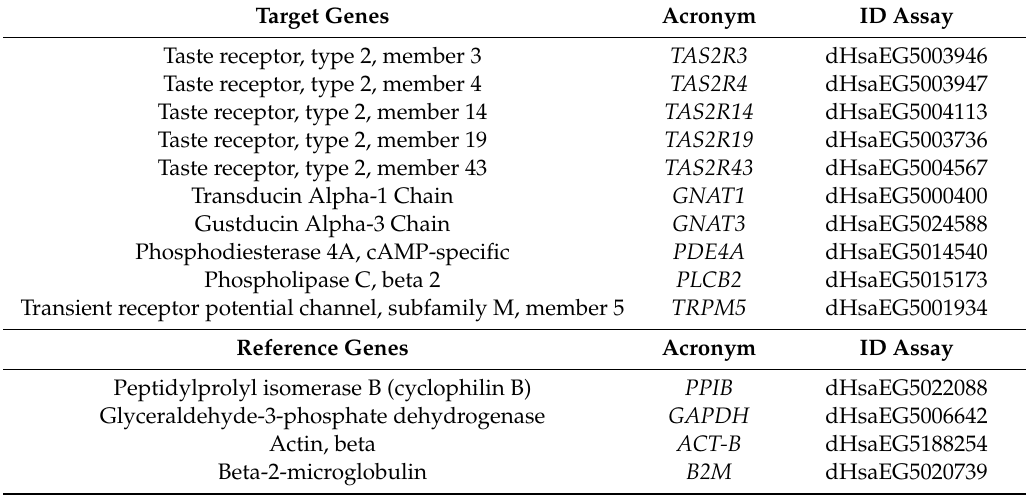
Table 1. PrimePCR EvaGreen Assay, specific for Droplets Digital Polymerase Chain Reaction. cAMP, Cyclic adenosine